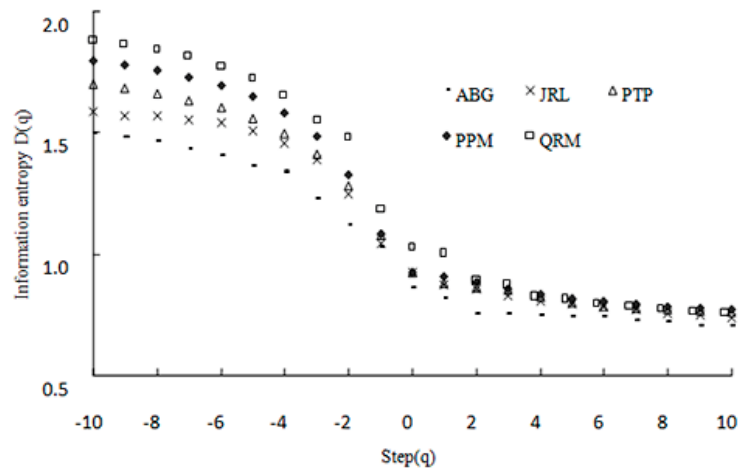
Figure 3. Multifractal spectra of soil PSD under the different vegetation types in the study area QRM— Quercus Acutissima Carr. and Robina Pseudoacacia Linn. mixed plantation; PPM— Pinus thunbergii Parl. and Pistacia chinensis Bunge mixed plantation; PTP— Pinus thunbergii Parl.; JRL— Juglans rigia Linn.; ABG—Abandoned grassland.